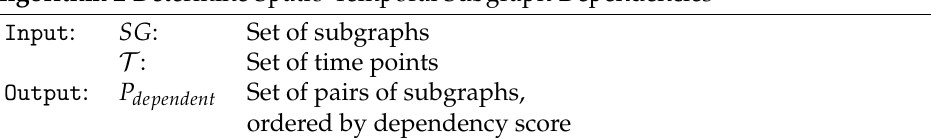
Algorithm 2 Determine Spatio-Temporal Subgraph